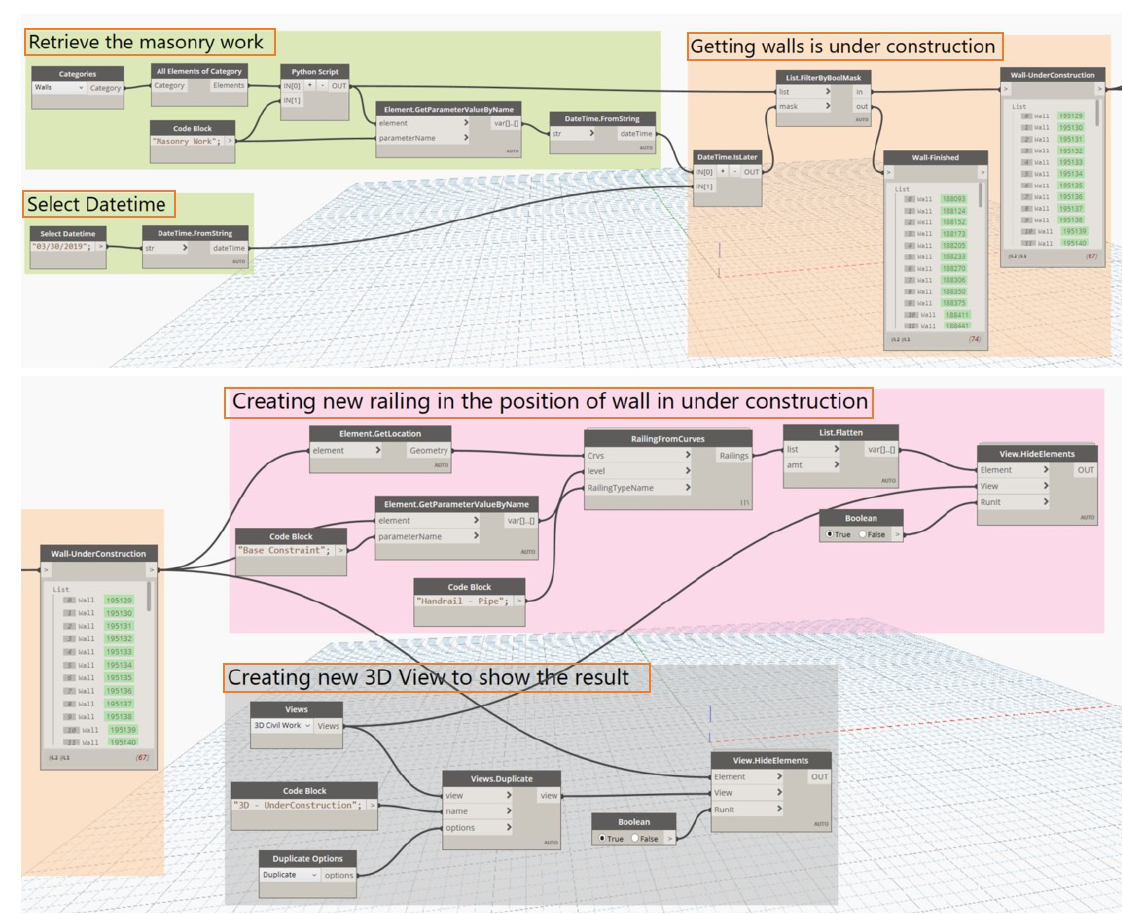
Figure 11. Placing temporary railing